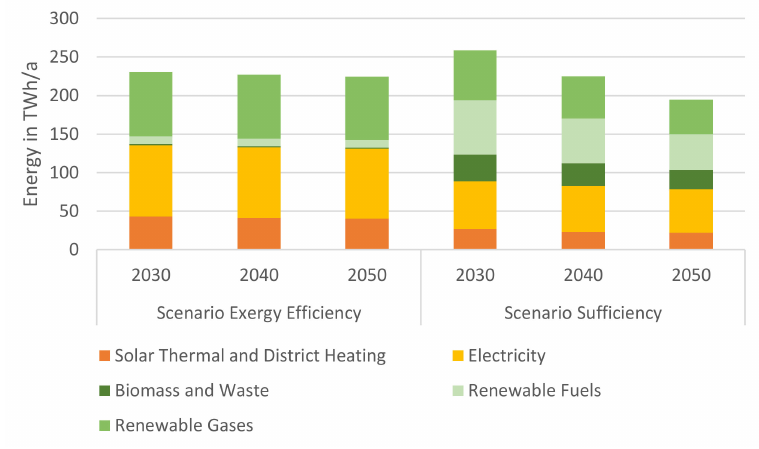
Figure 4. Comparison of the final energy consumption for both scenarios and all considered